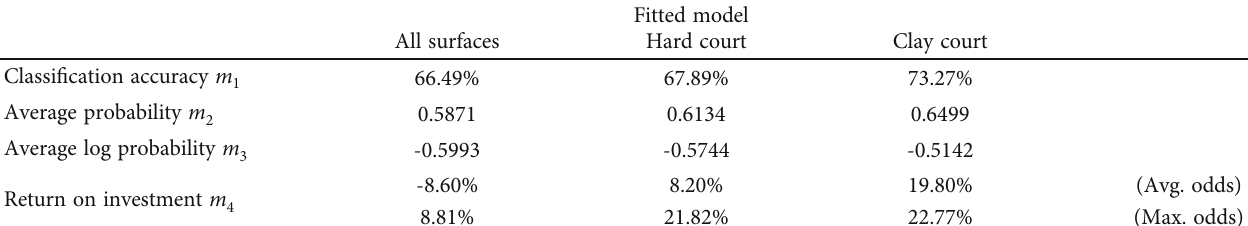
Figure 9: Match by match comparison of predicted probability with implied probability from bookmakers ’ average and best odds on clay court. Table 7: Measures of predictive performance for fi tted model.